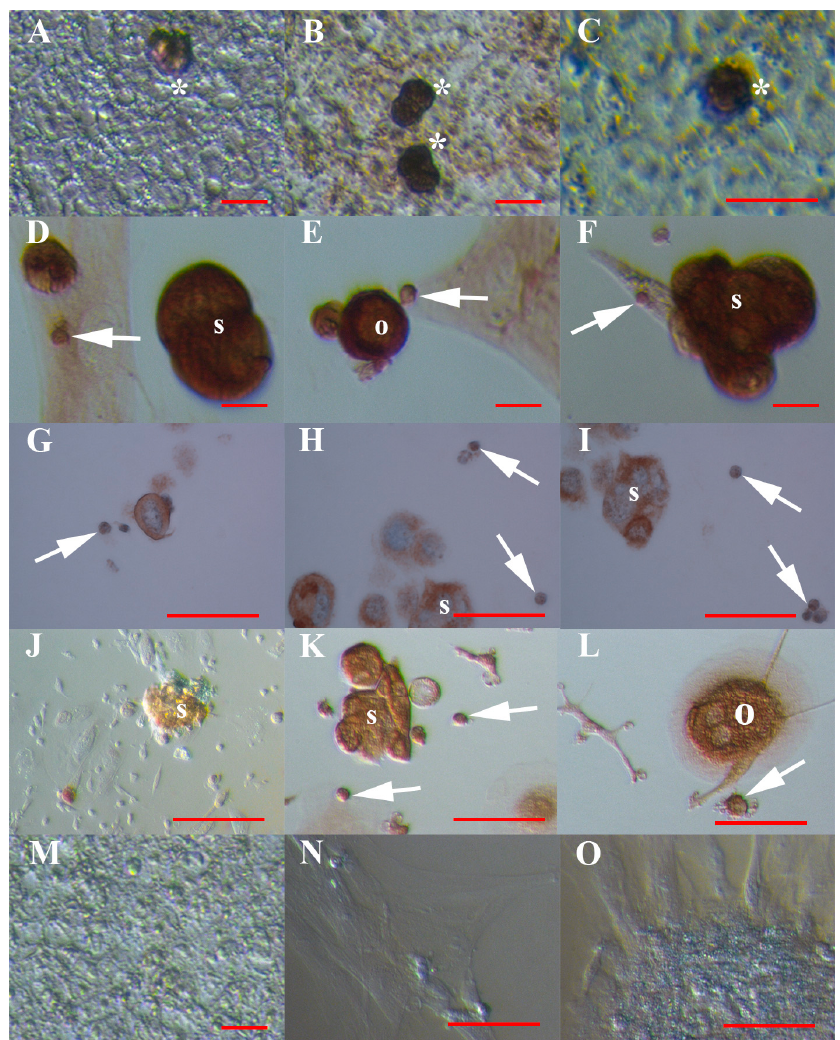
Figure 6. Positive (brown) staining of VSEL-like stem cells (arrows) with diameters of up to 5 μ m, cell clusters (asterisks), spheroids (s) and oocyte-like cells (o) for germinal lineage markers using the DAB method of immunocytochemistry. ( A – C ) DDX4-positive cell clusters in hESC cell cultures; ( D,F ) DDX4-positive spheroids and VSEL-like stem cells and ( E ) DDX4-positive oocyte-like cells and VSEL-like stem cells in cultures of ascites cells from recurrent ovarian cancer; ( G – I ) DDX-4-positive larger cells in spheroids and VSEL-like stem cells in ascites of recurrent ovarian cancer; ( J,K ) PRDM14-positive spheroids and ( L ) PRDM-14-positive oocyte-like cell with a diameter of around 60 µ m and surrounded by a structure resembling the zona pellucida of human oocytes, and VSEL-like stem cells; and ( M – O ) negative controls. Inverted microscope (Ho ff man illumination). Red bar: 10 µ m for A– F , M; 50 µ m for G-I, K, L, N, O; 100 µ m for